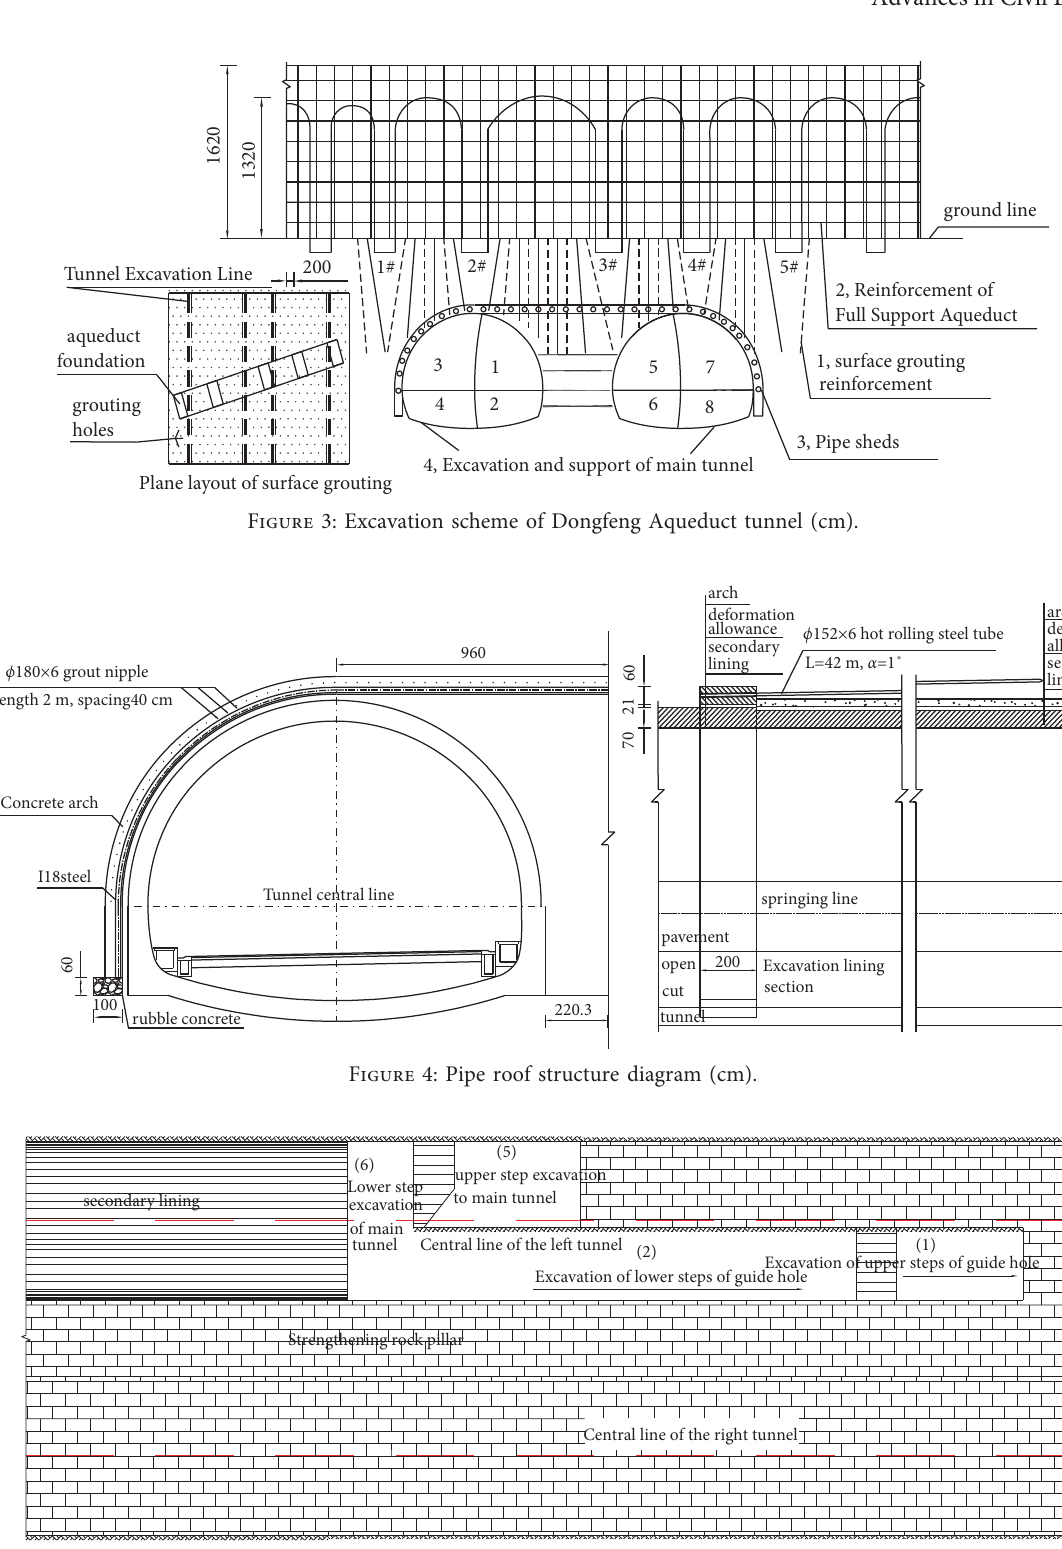
Figure 5: Excavation step diagram.